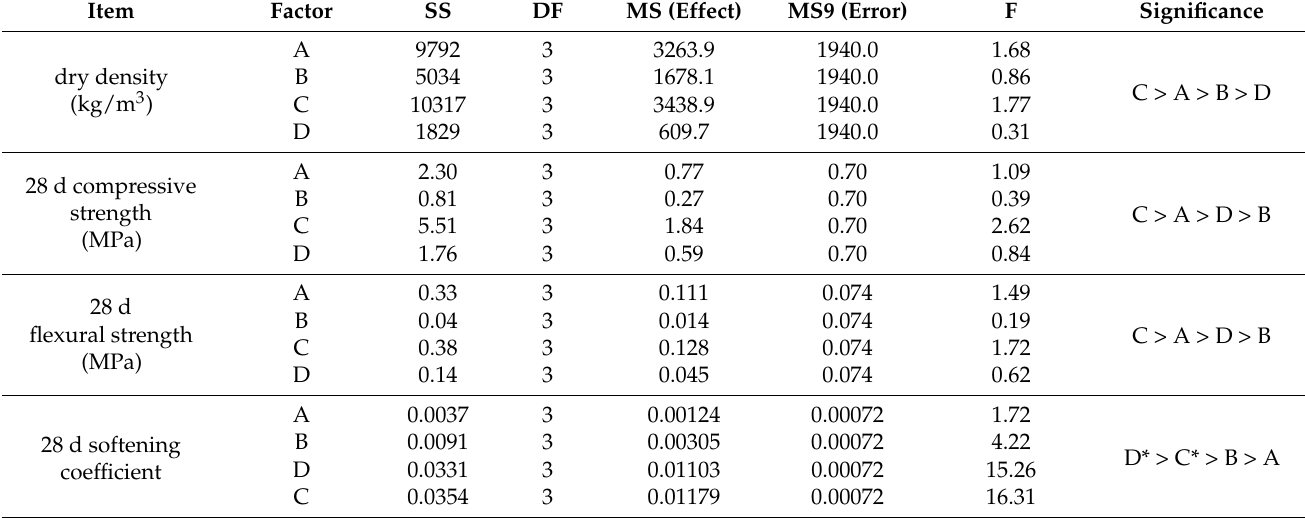
Table 6. Results of